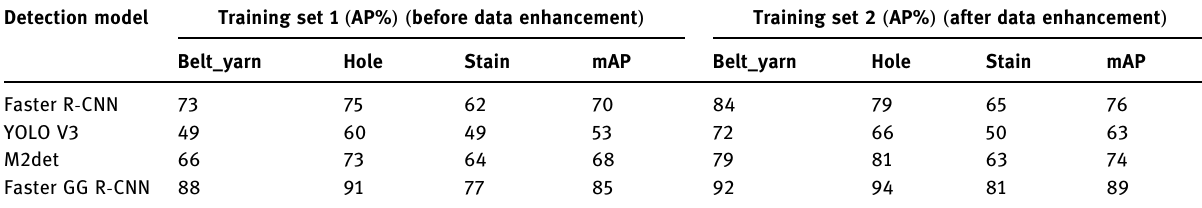
Table 3: The fabric defect detection results of the three models Detection model